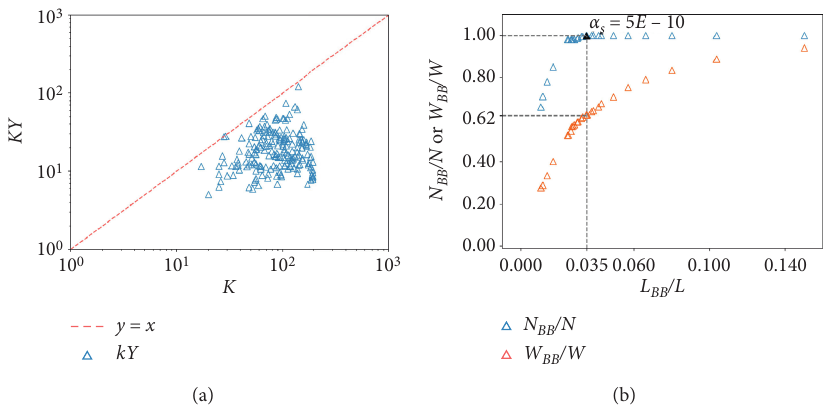
/ N and W / W versus L / L in the period of 2010–2015. BB BB BB